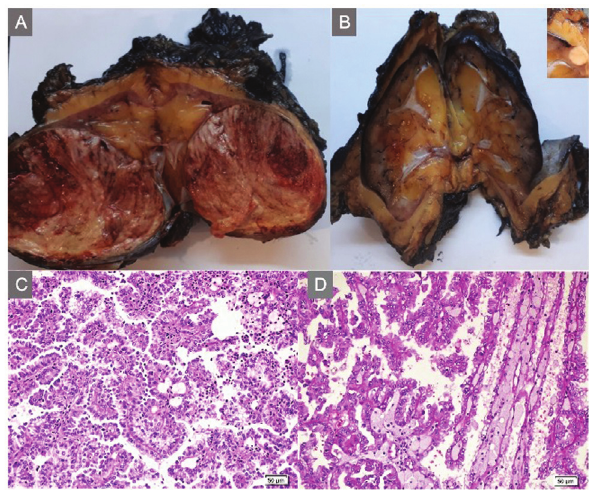
Fig. 2 ( A ) The excised right-sided tumor with prominent pseudo-